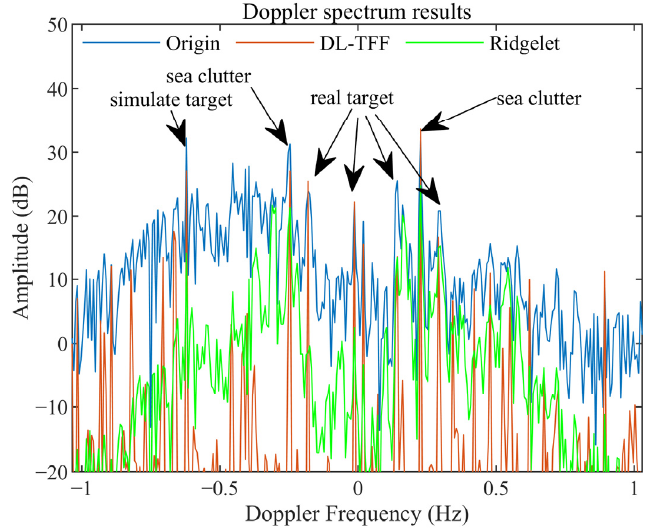
Figure 12. Comparison results between ridgelet analysis and proposed DL-TFF framework.